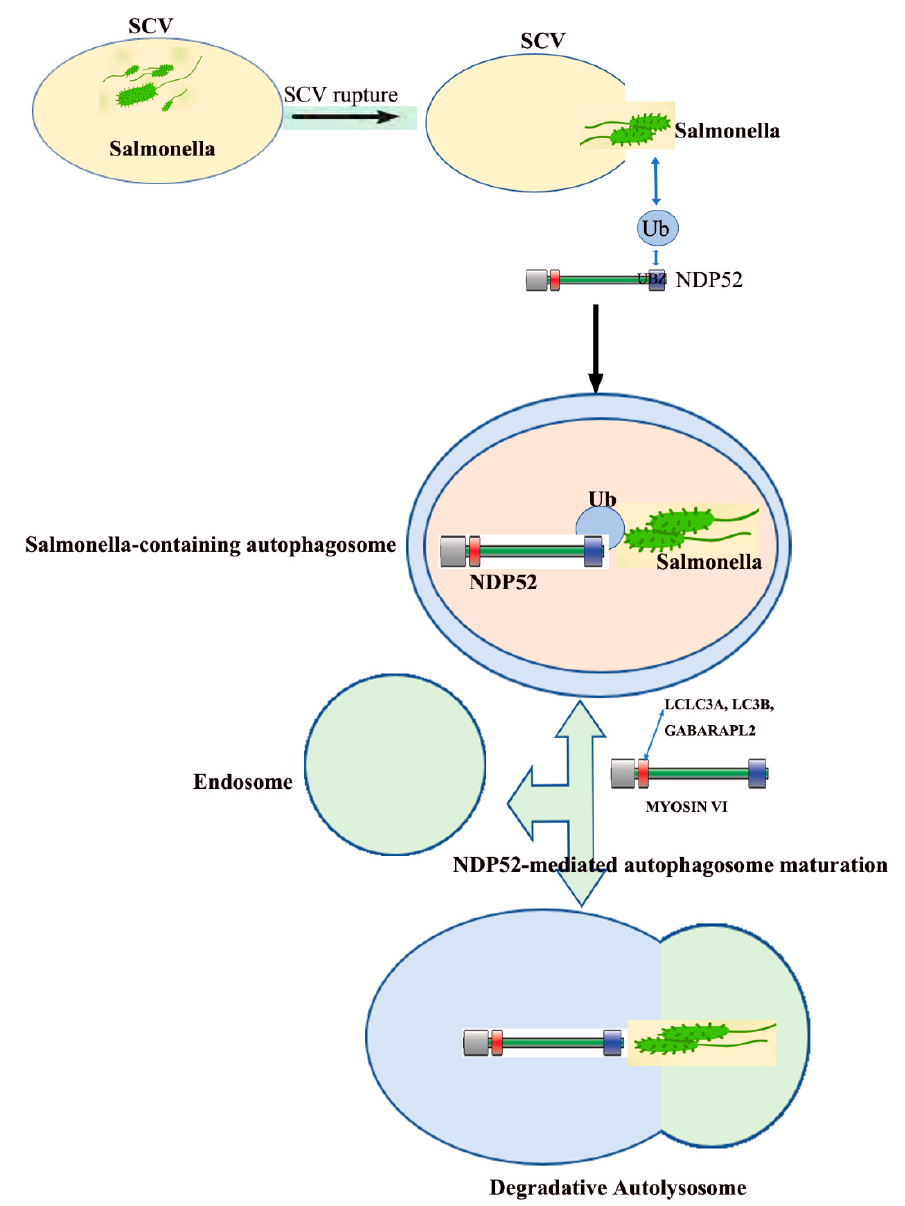
Figure 3. Dual role of NDP52 in Salmonella infection. Salmonella colonizes within Salmonella -containing vesicles (SCV) and replicates itself. After the vesicles burst, they are released into the cytoplasm and reproduce in large numbers. NDP52 identify and target Salmonella that are released into the cytoplasm through its UBZ domain and LC3c binding site (CLIR motif), and, independently, regulates autophagosome maturation through its LC3a, LC3b, or Gabarapl2 binding site (LIR-like motif) and its Myo6 interacting region (modified from [37]).